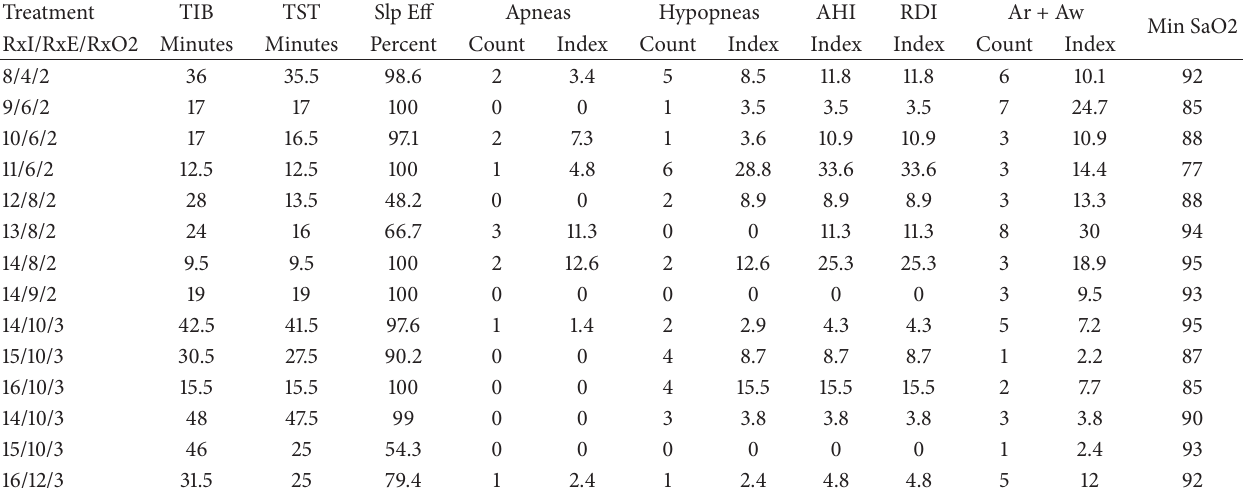
Table 8: Treatment parameters and results/with dual